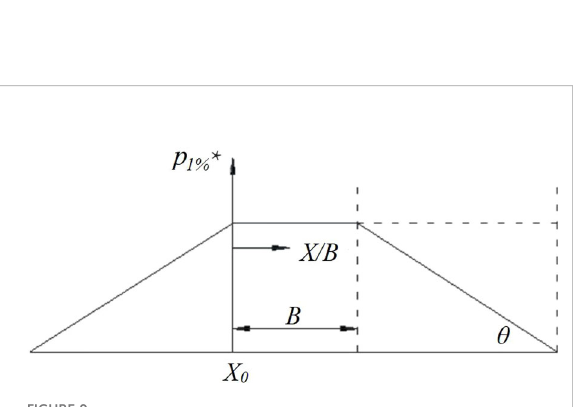
FIGURE 9 Coordinates of the relative normal stress variation along the dike.